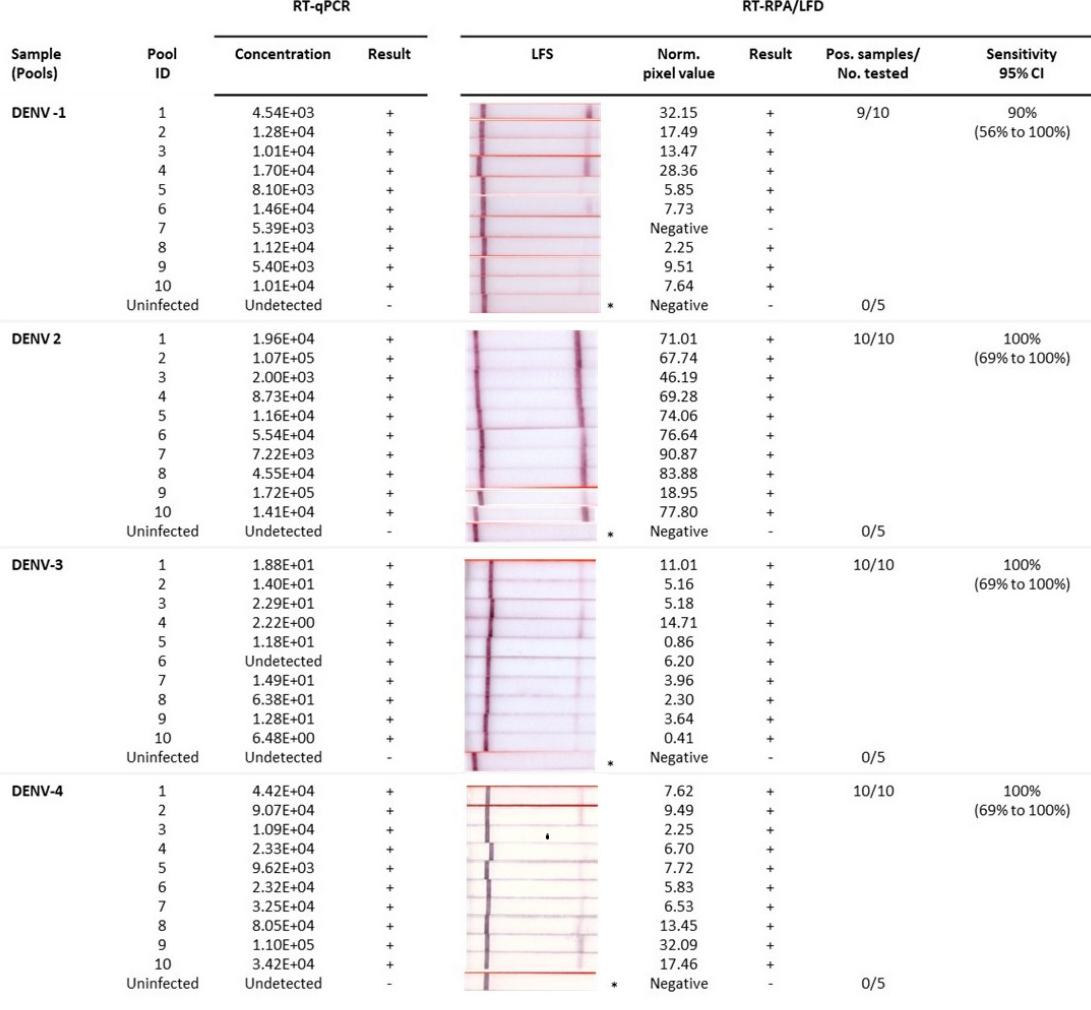
Figure 6. Detection of uninfected and infected mosquito pools by rapid dengue virus (DENV) 1–4 reverse-transcription recombinase polymerase amplification lateral flow detection (RT-RPA/LFD) assays and reverse-transcription quantitative polymerase chain reaction (RT-qPCR). Sample: Pools containing 1 infected DENV-1, DENV-2, DENV-3, or DENV-4 in a pool of 4 uninfected mosquitoes; Pool ID: Serotype-specific mosquito pool identification (ID) number; RT-qPCR: concentration (copies/µL) of respective pooled mosquito head extracts tested and corresponding result (+/-); RT-RPA/LFD: Image of lateral flow strip (LFS) result from RT-RPA/LFD testing the corresponding pooled mosquito body extracts using the respective serotype RT-RPA/LFD test [Images of lateral flow strips with two bands (control and test band) indicates the sample is positive for respective DENV, and single control band indicates a valid reaction with negative sample]; Blank normalized (Norm.) black pixel value from the lateral flow strip and corresponding result (+/-); Number of mosquito pools that tested positive (Pos.) compared to the total number (No.) of mosquito pools tested with the respective DENV assay; and Sensitivity of the RT-RPA/LFD assay with 95% confidence interval (CI). *One representative lateral flow strip shown for uninfected mosquito pool